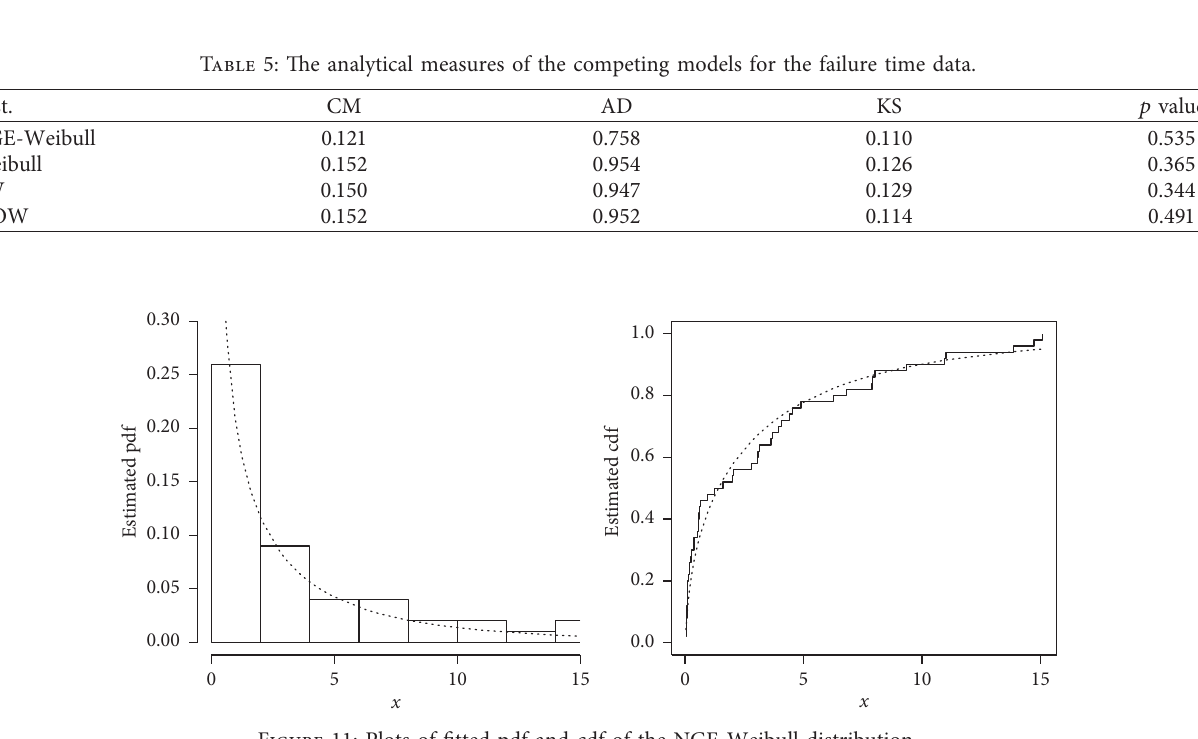
Figure 11: Plots of fitted pdf and cdf of the NGE-Weibull distribution.